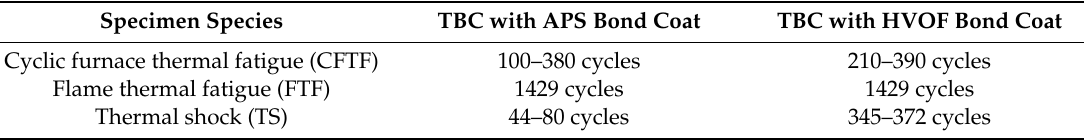
Figure 5. Surface micrographs and cross-sectional microstructures of TBCs after TS tests: TBC with APS bond coat (the surface micrographs ( a–1 ), cross-sectional ( a–2 ) and magnified interface ( a–3 ) microstructures) and TBC with HVOF bond coat (the surface micrographs ( a–1 ), cross-sectional ( a–2 ) and magnified interface ( a–3 ) microstructures). Table 3. Thermal durability of TBCs with bond coat species in various thermal exposure tests.